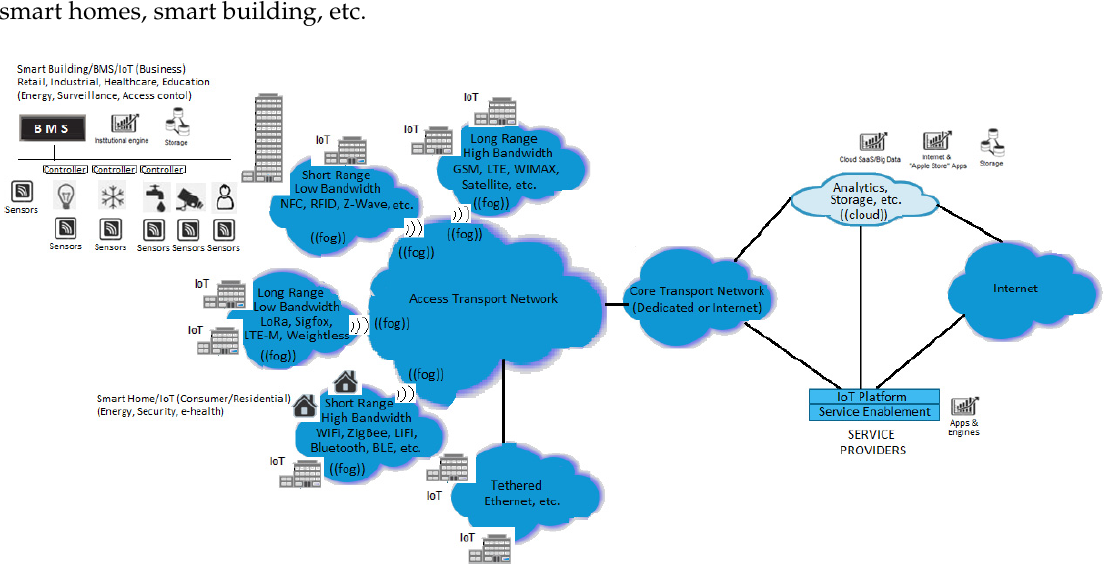
Figure 20. Global IoT-environment solution for smart concepts [59].